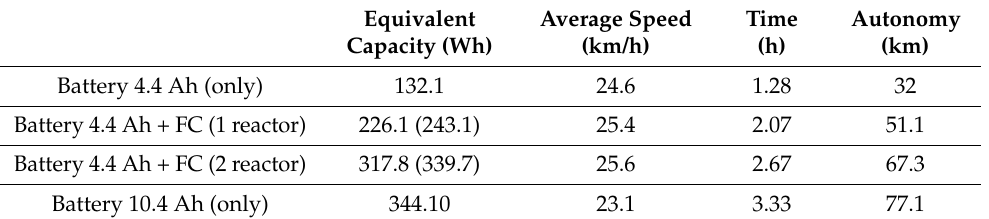
Table 4. Comparison of results between batteries and the hybrid system with FC.